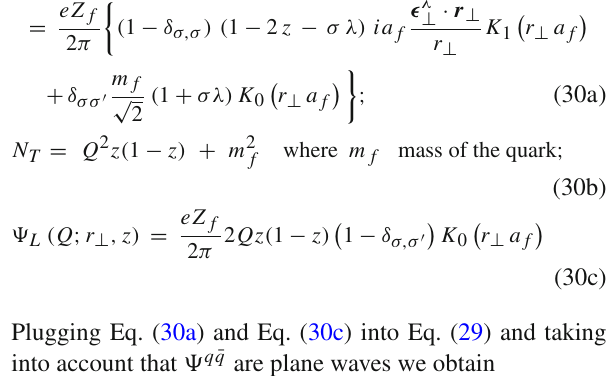
and N 4 as we did deriving el el